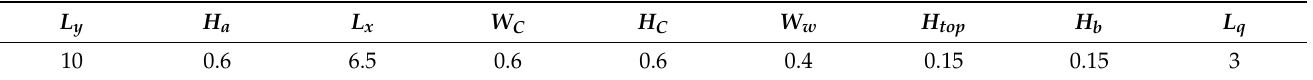
Table 2. Dimensions of the micro-channel heat sink (unit: